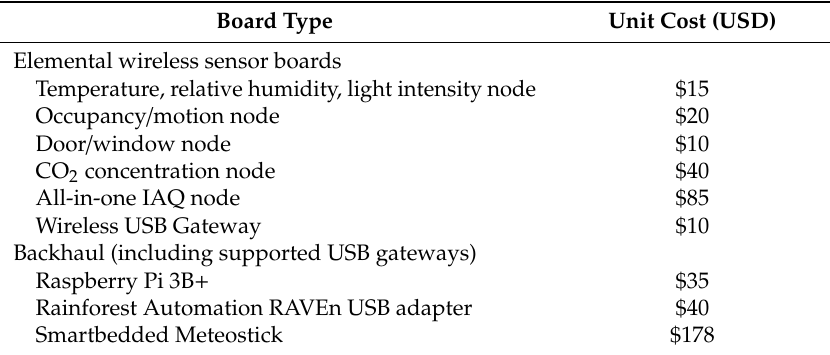
Table 2. Total unit cost of Elemental wireless sensor family and backhaul.